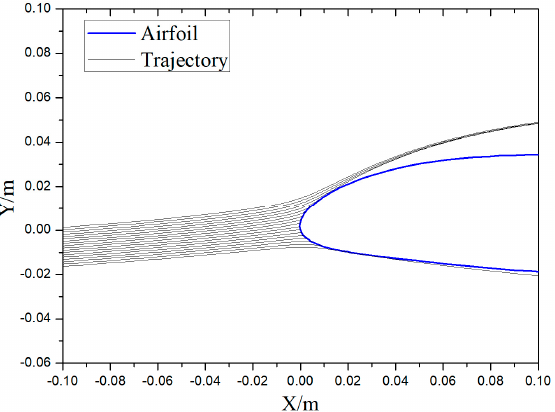
Figure 5. Droplet trajectories for the NACA23012 verification example.